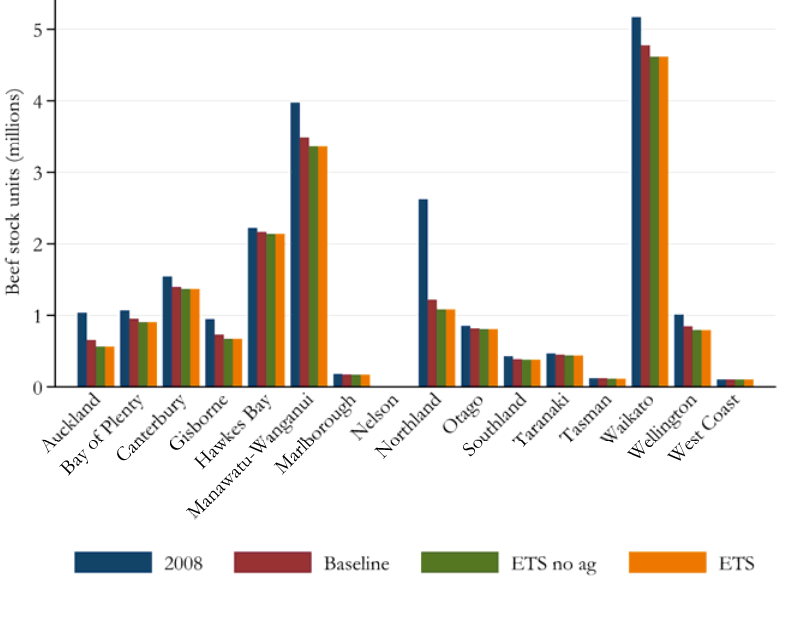
Figure 7. Beef stock units by region in 2008 and in 2030 policy scenarios. Blue bars show LURNZ estimates of the total stock units by regional council in 2008. Red, green and orange bars show, respectively, projected output in 2030 under the baseline, with an ETS that does not include agriculture, and under the full ETS. Details on stock unit projections are in Timar